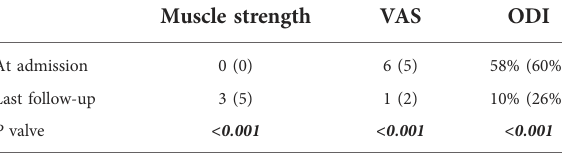
TABLE 2 Comparisons regarding muscle strength, VAS, and ODI (median and